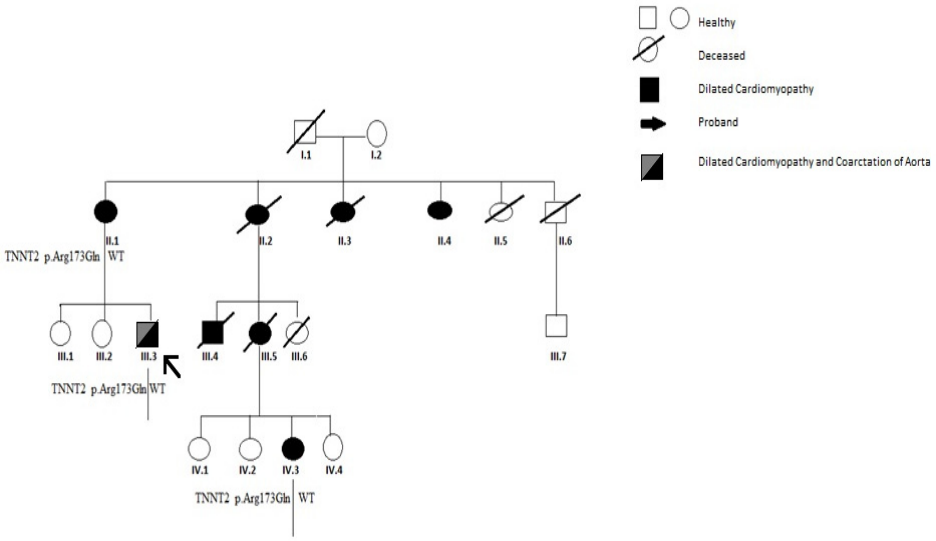
Figure 1. Family pedigree of the proband. Open symbols: phenotype negative. Full symbols: phenotype positive (affected by dilated cardiomyopathy). III,6 died suddenly at 3 months. II,2 III,4 underwent cardiac transplantation. II,2; II,3; III,4; III,5 died aged 42, 18, 24, 38 years old, respec- tively.